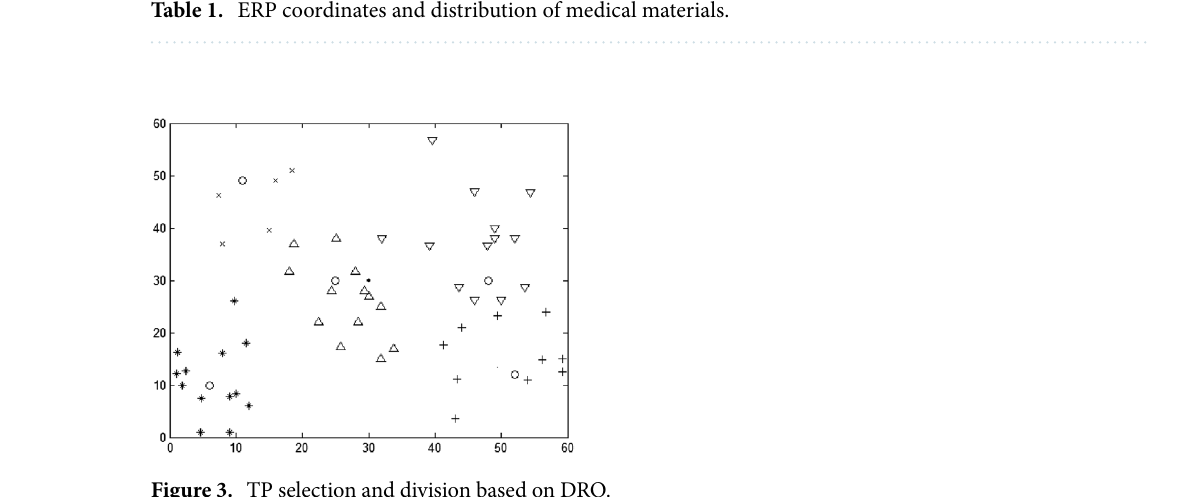
Figure 3. TP selection and division based on DRO.